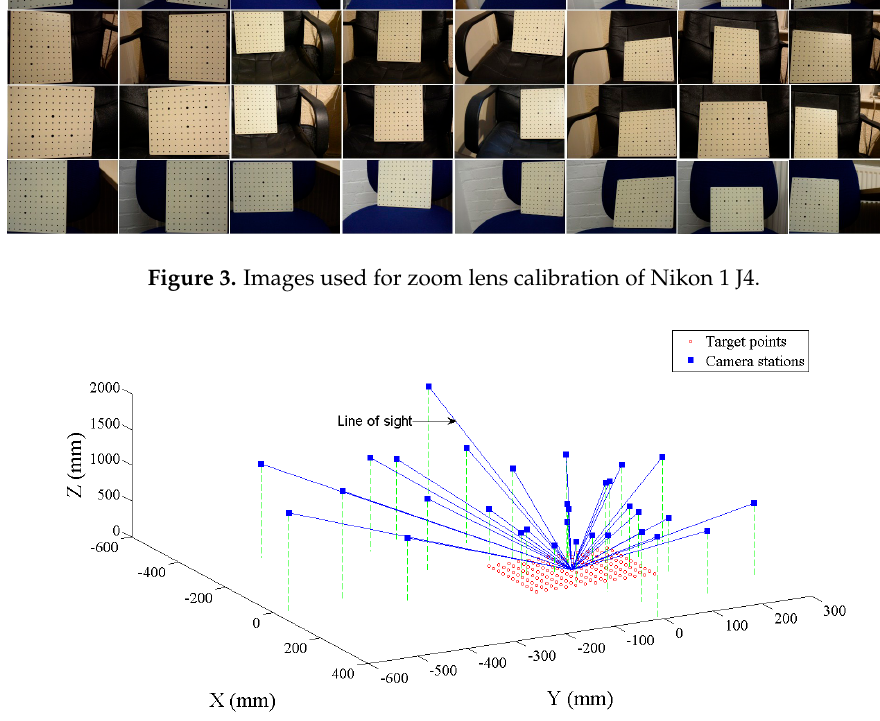
Figure 4. Image network configuration for zoom lens calibration of the Nikon 1 J4.